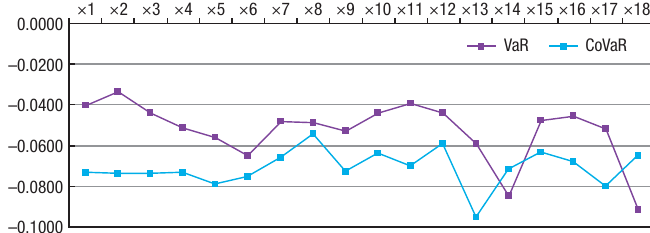
Fig. 2. Sector VaR and CoVaR conditional on 18 sectors